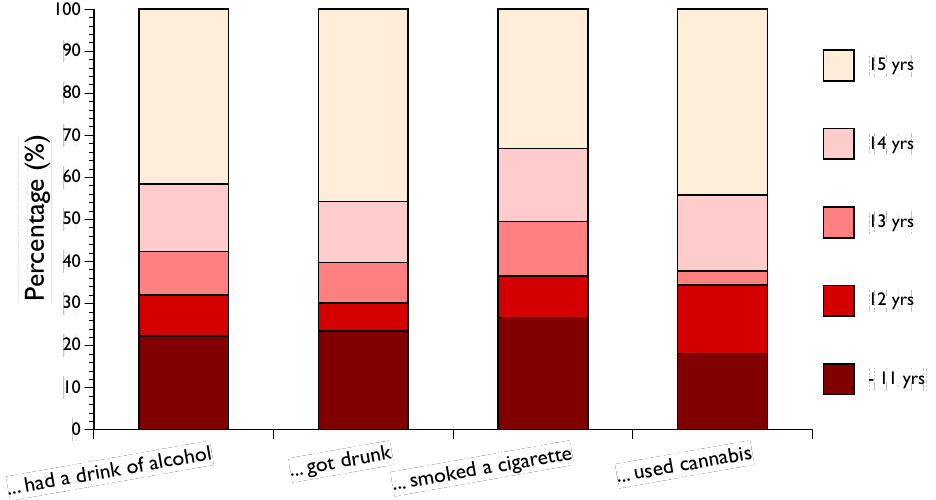
Figure 2. Age of initiation (years) amongst respondents who have begun AOD use.